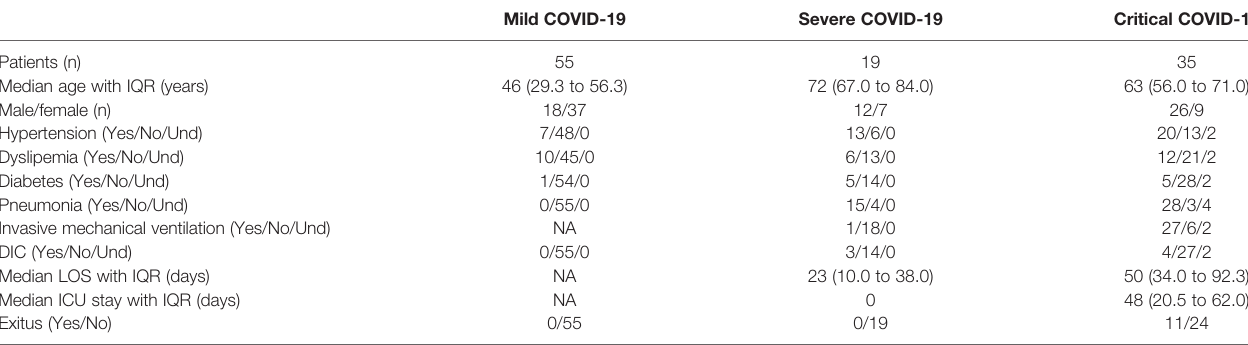
TABLE 1 | Summary of clinical data of patients with COVID-19 that participated in the